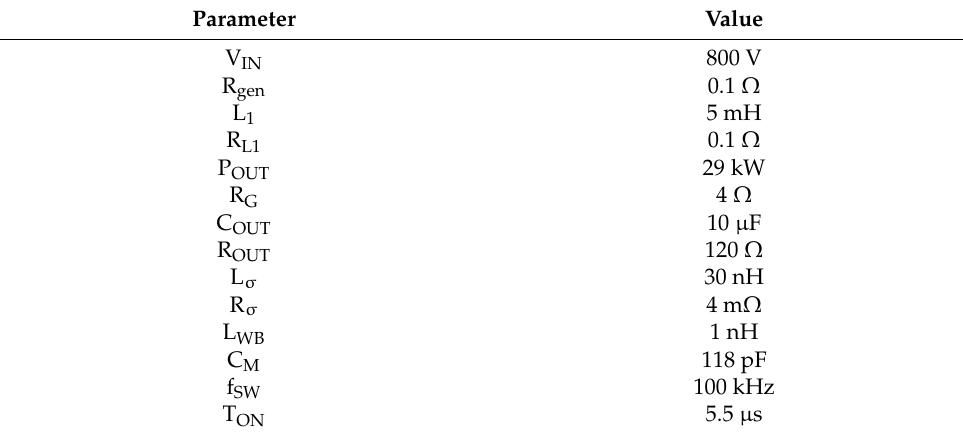
Table 2. Values of the DC-DC converter circuit parameters adopted in SIMetriX.